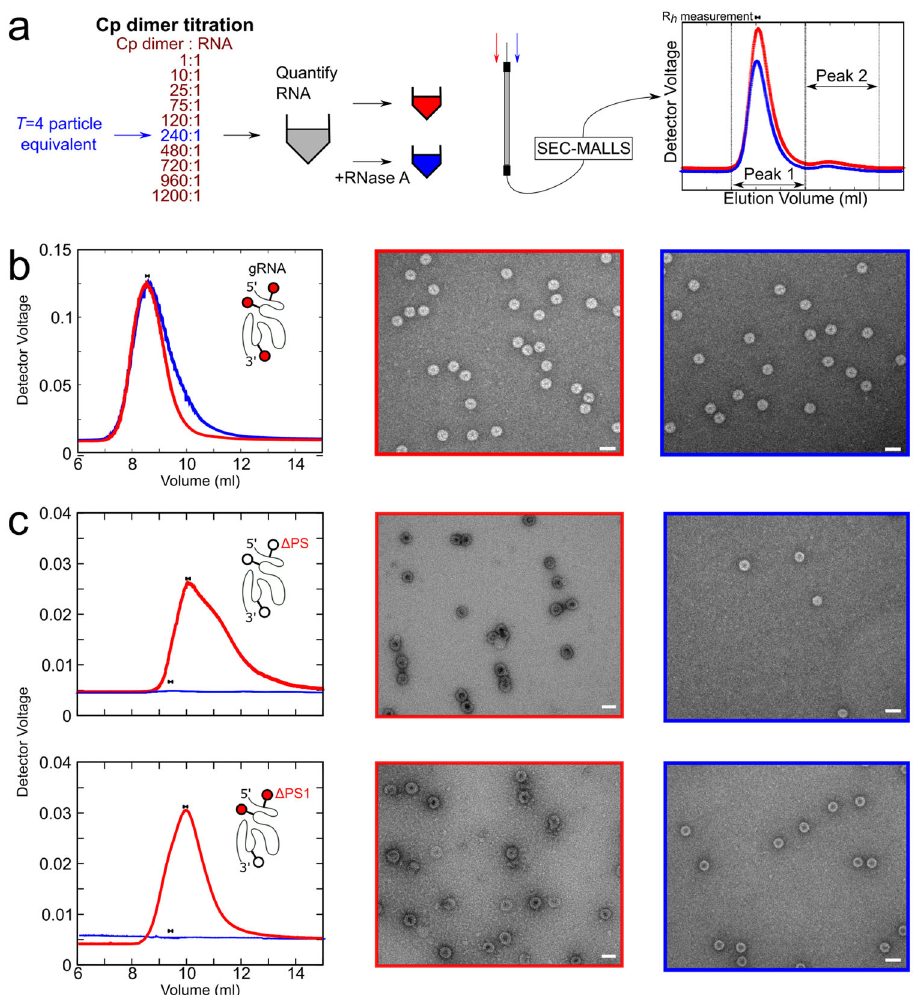
Fig. 3 Roles of PSs in regulation of in vitro assembly of HBV NCPs. a Cp dimer was titrated at 10 min intervals (left) into heat-annealed ( ‘ Methods ’ ) HBV gRNA transcript in a 96-well plate. Reactions were then pooled (grey) and split into 2 (red/blue), one of which was treated with RNase (blue). Aliquots of each were visualised by nsEM and the remaining sample analysed by SEC-MALLS chromatography, recording the elution volumes (graph, right) and hydrodynamic radii (R h , bar above peak) of particulate reassembly products from their light-scattering ( ‘ Methods ’ ). b Left: LS traces of the reassembly products with PS variants of 1 nM HBV gRNA and HBV Cp dimer: red and blue traces are pre- and post-RNase treatment, respectively. Middle/Right: nsEMs of the assembly products shown (left). Scale bars = 50 nm. c Left: LS traces, as in ( b ), with 1 nM Δ PS (top) and Δ PS1 (bottom), and Middle/Right: nsEMs of the assembly products shown. Data found in Supplementary Data